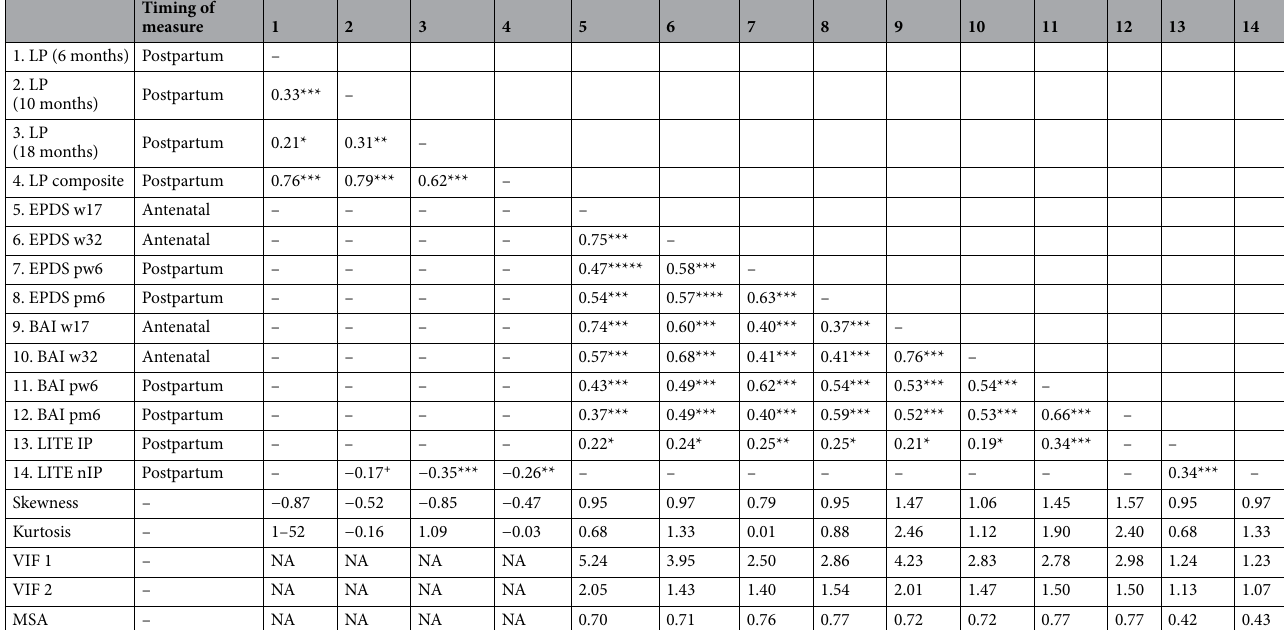
and it is reasonable to create a single construct. Second, to answer our research question, we used the focused attention measure to relate to 10 maternal variables. Reducing the number of variables is helpful to reduce the complexity of regression analysis and to better interpret the results. All tasks were recorded using an eye-tracker with a sampling rate of 60 Hz following a 5-point calibration (Tobii TX300, Tobii Technology AB, Sweden). Statistical analysis. Maternal psychological distress. We used multivariate linear regression models and a moderator analysis to examine the association between multiple predictors across different time points and the outcome measure. To assess the reliability of the maternal scale instruments, we calculated the internal consist- ency coefficient, Cronbach’s alpha for each tool: EPDS, 0.87, good; BAI, 0.81, good; and LITE, 0.9, excellent. Before adjusting their scores, the zero-order Pearson correlations (with Benjamini–Hochberg correction), skew- ness, and kurtosis of all variables were calculated (Table 4). The variance inflation factor (VIF) was calculated based on the assumption that infants’ look percentage is predicted by 10 variables from the EPDS (4 time points), BAI (4 time points), and LITE (1 time point). For the10 maternal variables, we performed a test of Missing Com- pletely at Random for multivariate data with missing value 115 . Given the p -value for the chi-squared statistic was 0.82, we can conclude that maternal variables are missing completely at random. As seen in Table 4, raw scores for anxiety symptoms during antenatal 17 weeks and postpartum 6 weeks are not in the acceptable range of the kurtosis index. The raw scores of the EPDS, BAI, and LITE did not reach the range of approximate symmetric distribution (kurtosis index acceptable range, −2 to + 2; skewness index acceptable range -0.5 to + 0.5) 116 . In ad- dition, the literature has shown that comorbidity of depression and anxiety is common 96,97 , so we expected to detect potential multicollinearity from the raw data. As seen in Table 4, the raw scores of the EPDS and the BAI during antenatal 17 weeks fit the strict criteria for multicollinearity (VIF1 > 4) with other variables 117,118 . Consid- ering the non-normal distribution and multicollinearity of the EPDS and BAI, the Kaiser–Meyer–Olkin test was used to examine the sampling adequacy (MSA) and transformed all raw scores from four time points into factor scores (MSA > 0.65) 119 . The percentage of missing values in EPDS and BAI at 4 different time points are–0.8, 0, 8, 12, and 8, 3, 5, 13.5–, respectively. Missing values were imputed using predictive mean matching 120 . Individual factor scores of the EPDS and BAI at four time points were calculated using the imputed values. The LITE raw scores, including IP and nIP, were the frequency of the occurrences. To be consistent in the analysis using the comparable values that can represent different levels, they were transformed into dichotomic variables based on the median of the raw scores to interpret the interaction. This choice was made due to (1) the asymmetrical distribution of the raw scores (see Table 4, the value of skewness of nIP and IP); (2) the infrequent occurrence